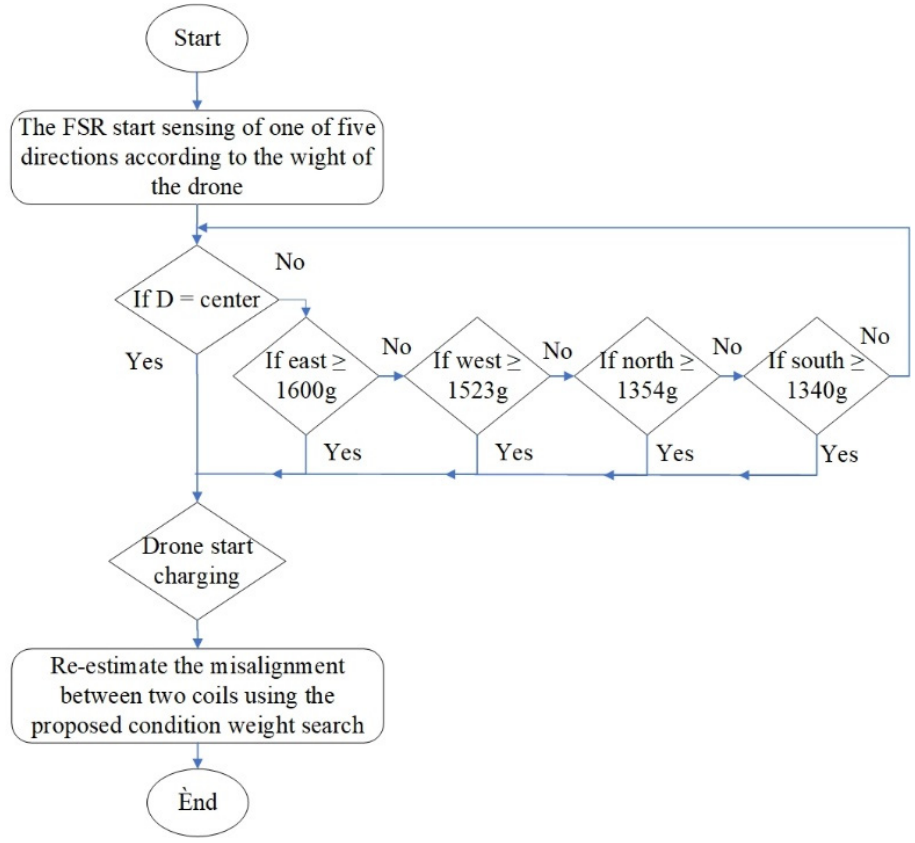
Figure 10. The flowchart of methodology used to solve the different distances and direction of vertical alignment and lateral misalignment.